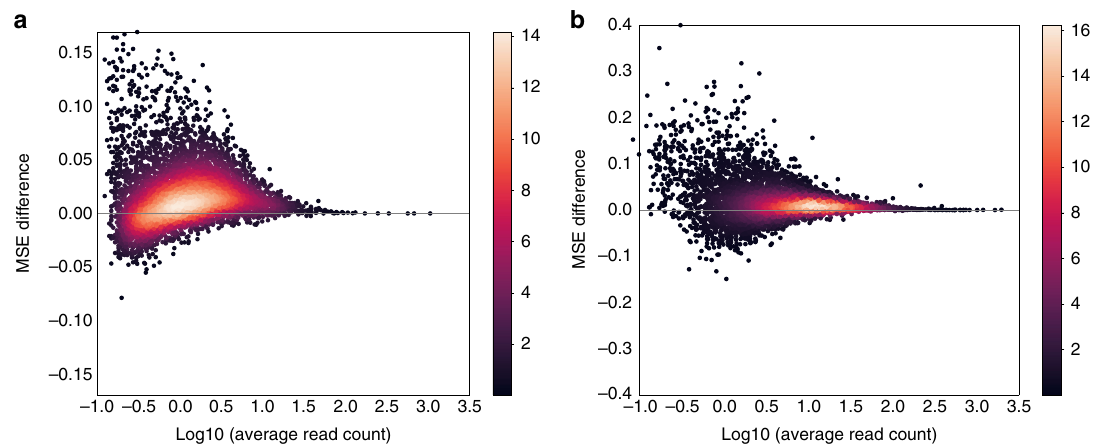
Fig. 3 Partial pooling improves the accuracy of estimated allelic proportions. We randomly sampled 1% of reads from the full data of 122 mature blastocyst cells to obtain a sub-sample of 147,538 reads per cell, on average. We estimated gene- and cell-speci fi c allelic proportions from the sub-sampled data, and computed mean squared error (MSE) between the estimated allelic proportions from the full data versus the sub-sampled data. We compared the MSE based on partial pooling versus the MSE from no pooling estimates, and display the difference (before (cid:4) after partial pooling) on the y -axis along the expression level in unique-read counts on the x -axis. We made this comparison for a unique reads and for b weighted allocation. Points representing individual genes are shown as a density